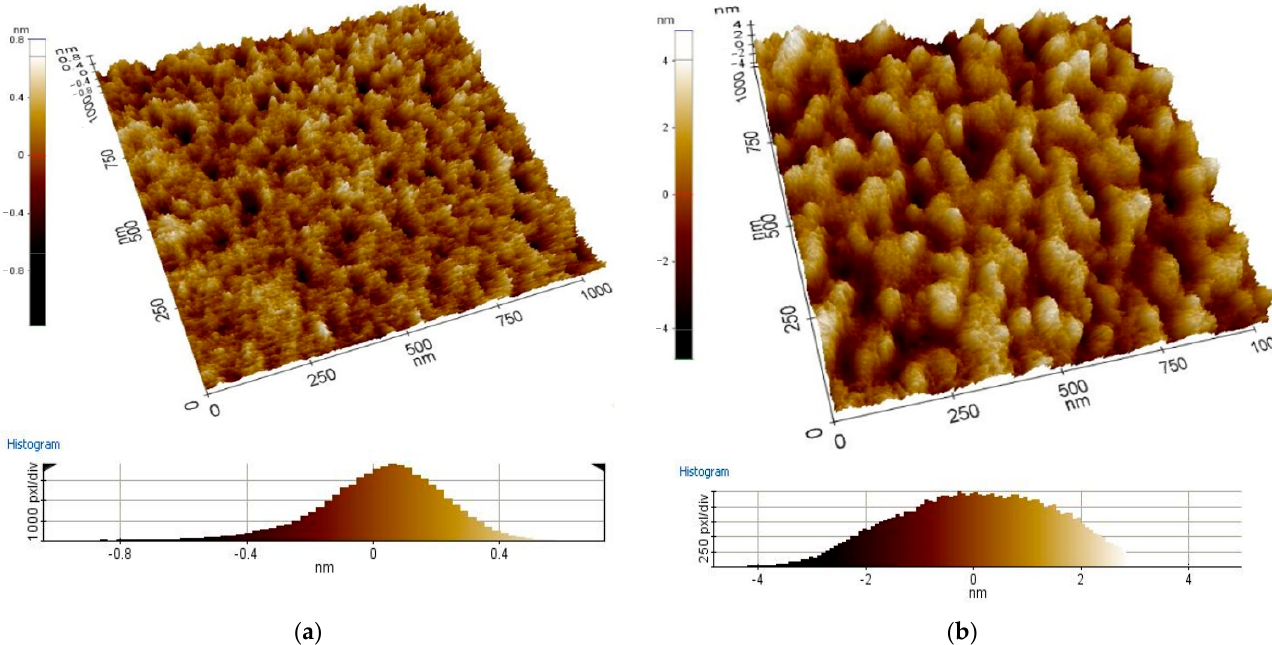
Figure 1. Topography of the applied In 2 O 3 layers with thickness ( a ) 25 nm, ( b ) 135 nm (chosen example) (AFM).